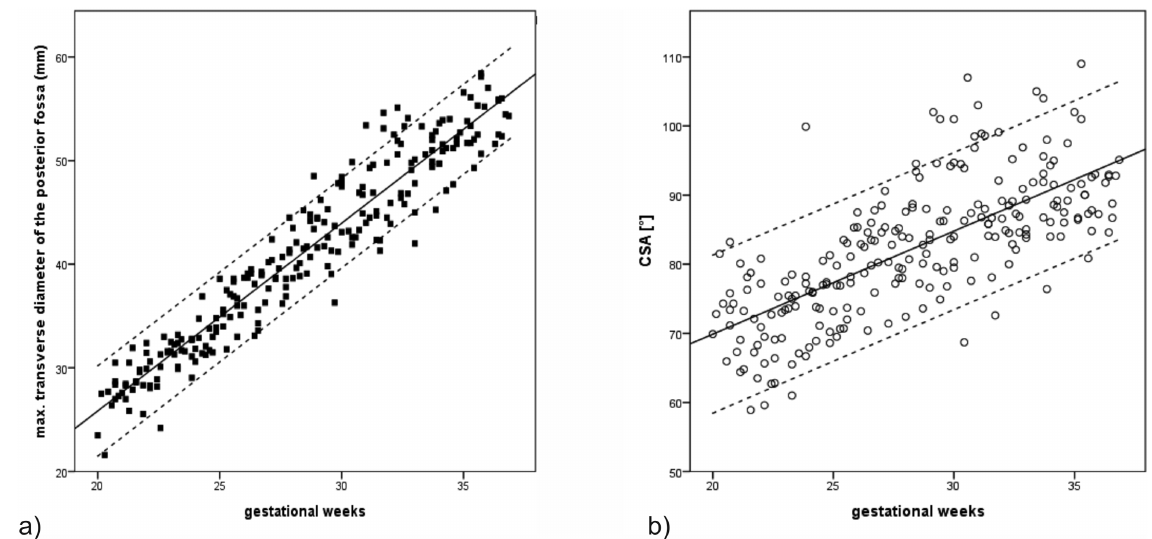
Figure 5. Correlations of the TDPF and CSA with gestational age. a) Correlation between the TDPF and gestational age in 238 fetuses with normal CNS development. Squares show TDPF values. The regression line is continuous (r=.956; p , .001). Dashed lines show calculated 10th and 90th percentiles. b) Correlation between the CSA and gestational age. Circles show CSA values of 238 fetuses with normal CNS development. The regression line is continuous (r=.714; p , .001). Dashed lines show 10th and 90th percentiles.